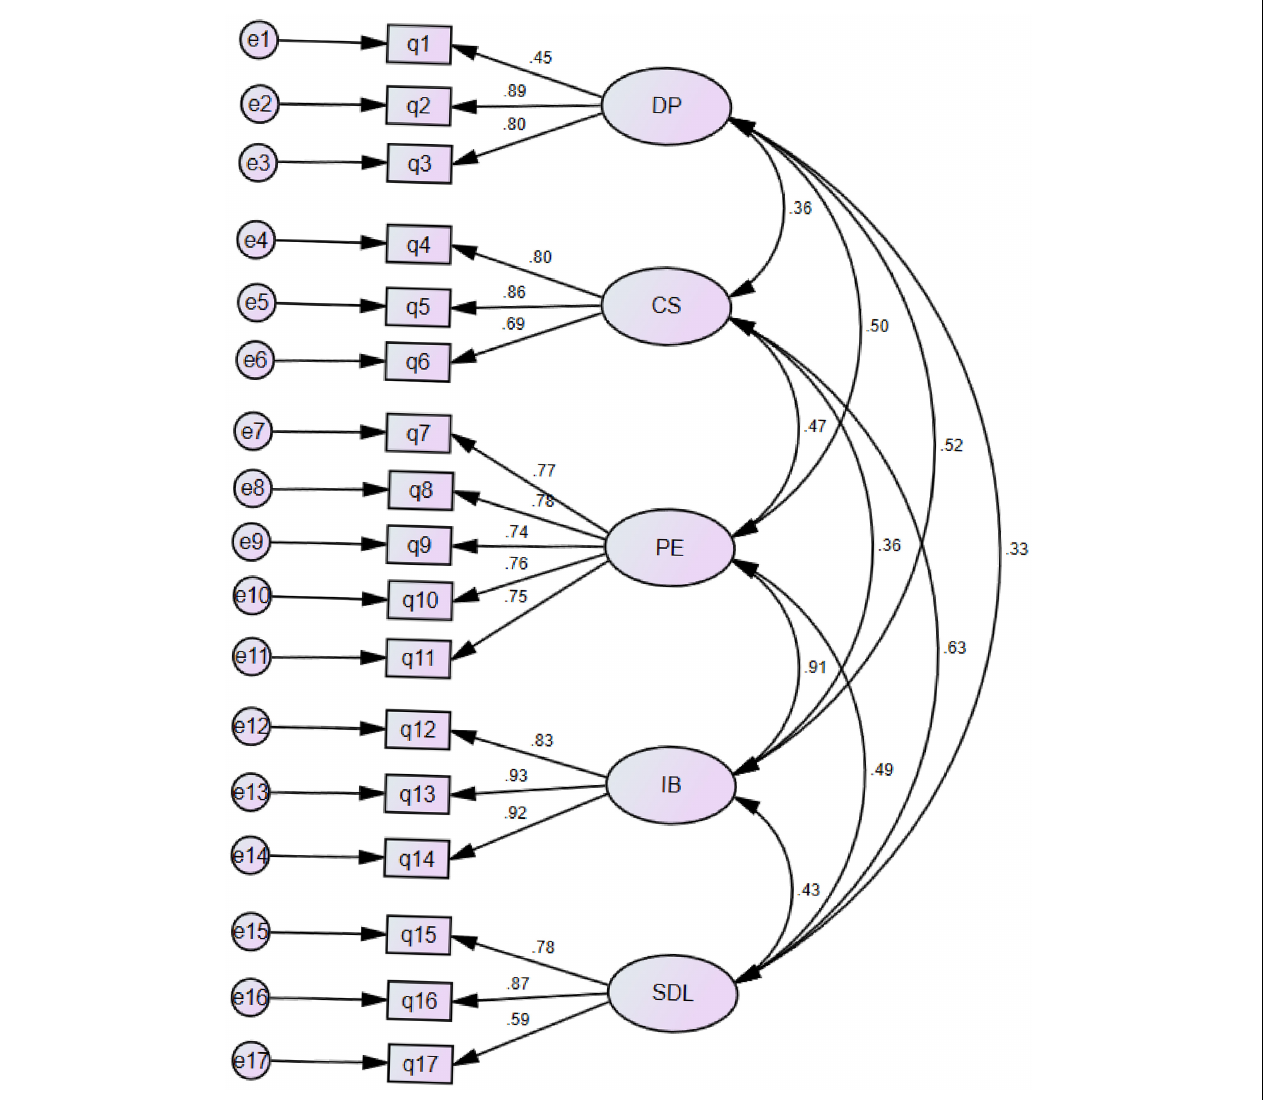
FIGURE 1 | Results of the CFA, a Five-Factor Model of the flipped English learning readiness questionnaire. DP, doing previews; CS, in-class communication self-efficacy; PE, positive experience of flipped classroom; IB, intentional behaviors; SDL, self-directed